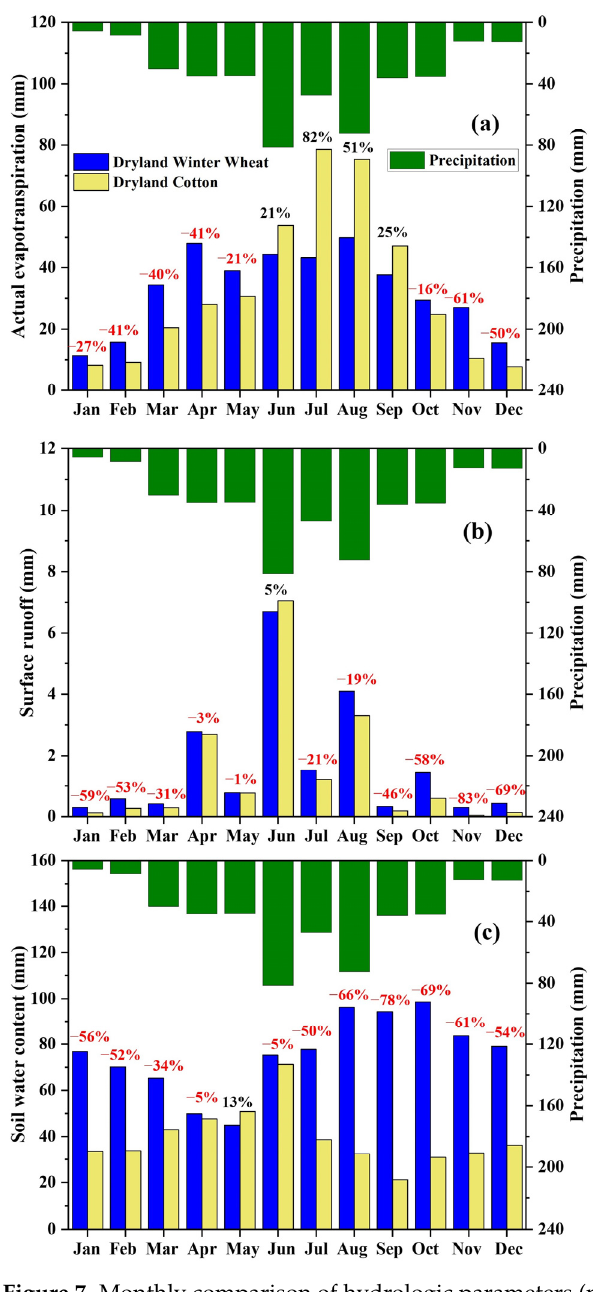
Figure 7. Monthly comparison of hydrologic parameters (mm) under the baseline dryland winter wheat and the land-use change scenario of dryland cotton in the Palo Duro watershed. Actual evapotranspiration ( a ), surface runoff ( b ), and soil water content ( c ).